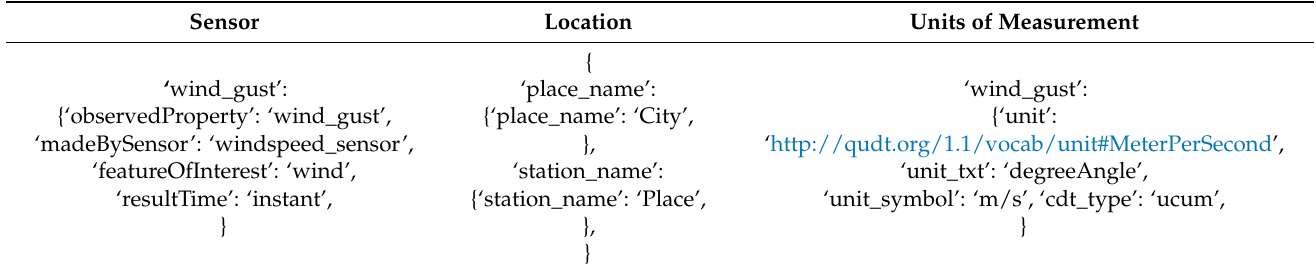
Table 8. Dictionary for wind gust descriptions.